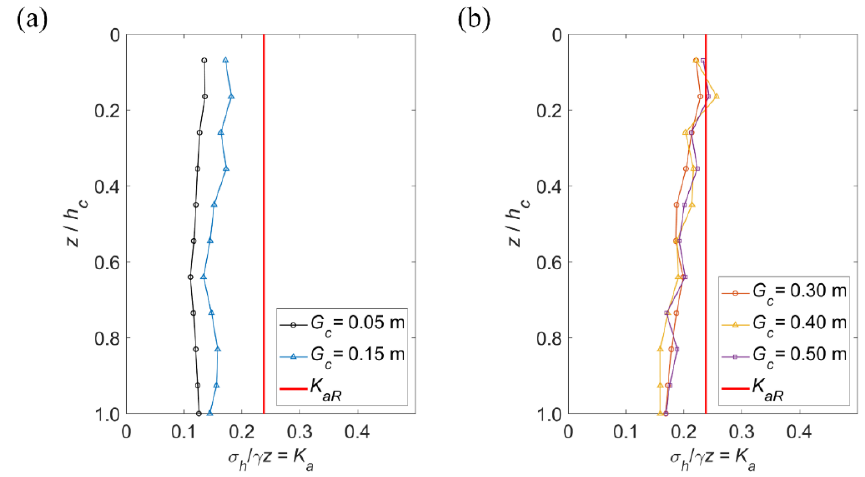
Figure 10. Relative magnitude of the measured coefficient of active earth pressure with respect to Figure 9. Vertical profiles of the normalized pressures when ( a ) G c < G cR and ( b ) G c ≥ G cR . Figure 9. Vertical profiles of the normalized pressures when ( a ) 𝐺 (cid:3030) < 𝐺 (cid:3030)(cid:3019) and ( b ) 𝐺 (cid:3030) ≥ 𝐺 (cid:3030)(cid:3019) . In Figure 10, the vertical profiles of 𝐾 (cid:3028) /𝐾 (cid:3028)(cid:3019) are presented, illustrating the relative magnitude the normalized earth pressure with respect to Rankine’s coefficient. In the figure, the depth-averaged value of 𝐾 (cid:3028) /𝐾 (cid:3028)(cid:3019) for each 𝐺 (cid:3030) condition is also shown as a dot- ted line. As shown in Figure 10a, the values of 𝐾 (cid:3028) /𝐾 (cid:3028)(cid:3019) did not change significantly in the vertical direction when the shoulder width was smaller than 𝐺 (cid:3030)(cid:3019) . The averages of 𝐾 (cid:3028) /𝐾 (cid:3028)(cid:3019)